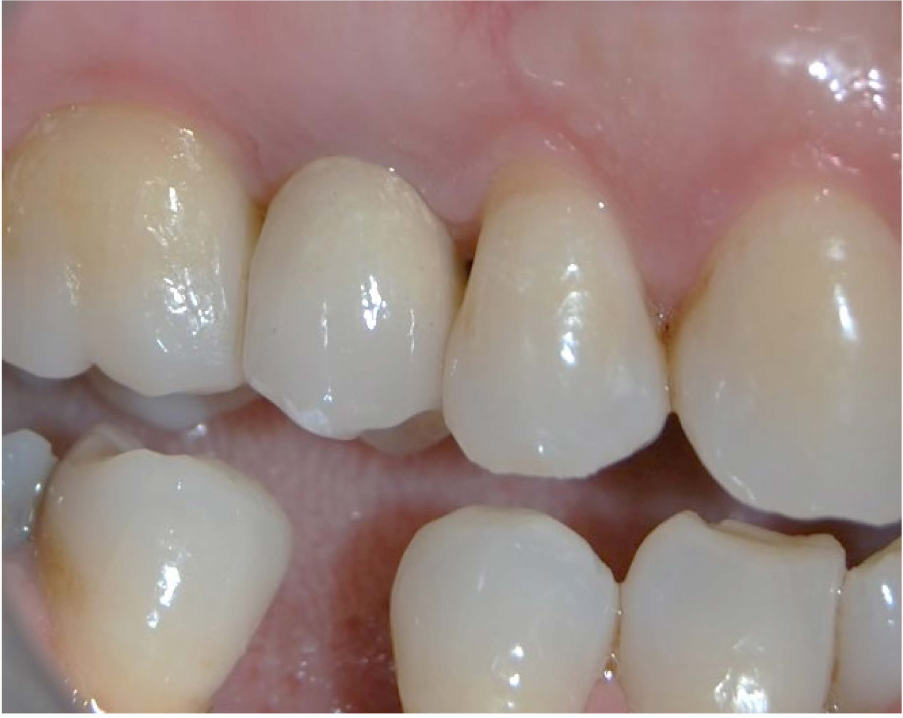
Figure 3. Clinical photo of the patient 10 years after the procedure.